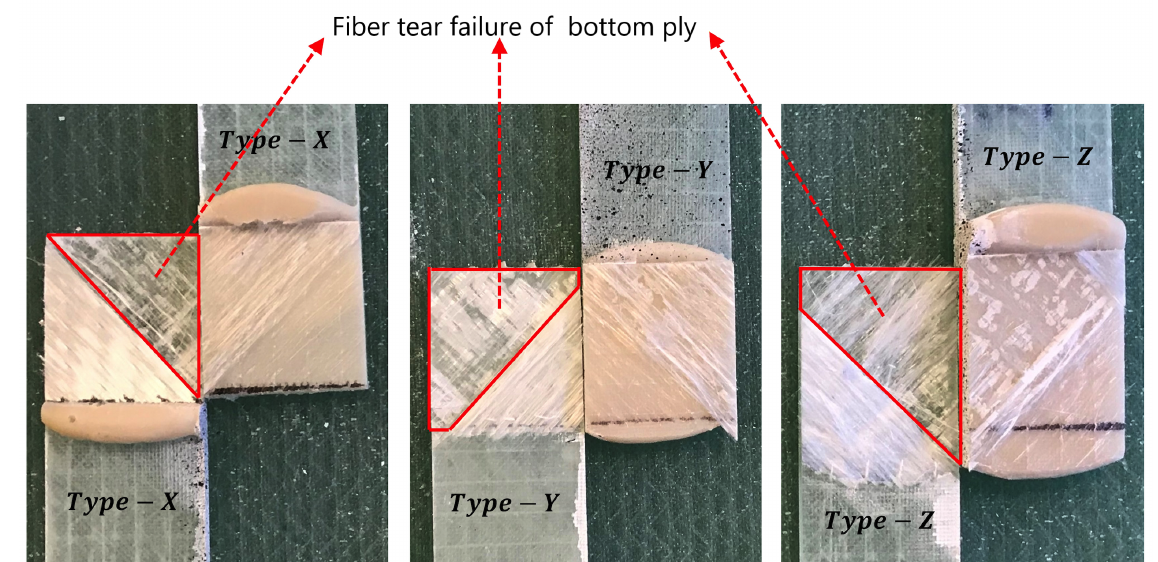
Figure 13. Failure mode subjected to tensile lap shear for joints with bondline thicknesses (0.6 mm, 1.6 mm, and 2.6